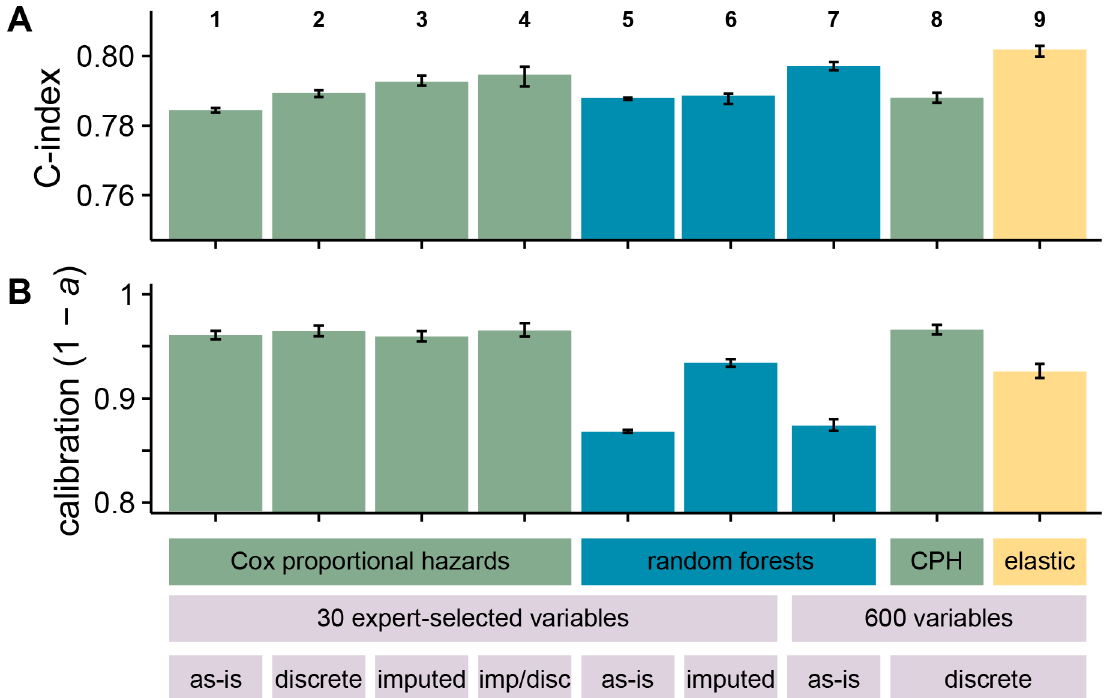
Fig 1. Overall discrimination and calibration performance for the different models and datasets used. (A) shows discrimination (C- index) and (B) shows calibration (1 − a , where a is the area between the observed calibration curve and an idealised one for patient risk at five years). Bar height indicates median performance across bootstrap replicates, with error bars representing 95% confidence intervals. Columns 1–4 represent variations on the Cox proportional hazards models using the 27 expert-selected variables used in Ref. [13]. Column 1 shows a model with missing values included with dummy variables; column 2 shows a model where continuous values have been discretised and missing values included as an additional category; column 3 shows a model where missing values have been imputed; and column 4 shows a model where missing values have been imputed and then all values discretised with the same scheme as column 2. Columns 5–7 show the performance of random survival forests. Column 5 uses the 27 expert-selected variables with missing values included with missingness indicators, and column 6 uses the imputed dataset. Columns 7 and 8 show models based on a subset of the 600 least missing variables across a number of different EHR data sources, selected by cross-validation. 7 is a random forest model with missing values left as-is, while 8 is a Cox proportional hazards model with continuous values discretised. Column 9 is an elastic net regression based on all 600